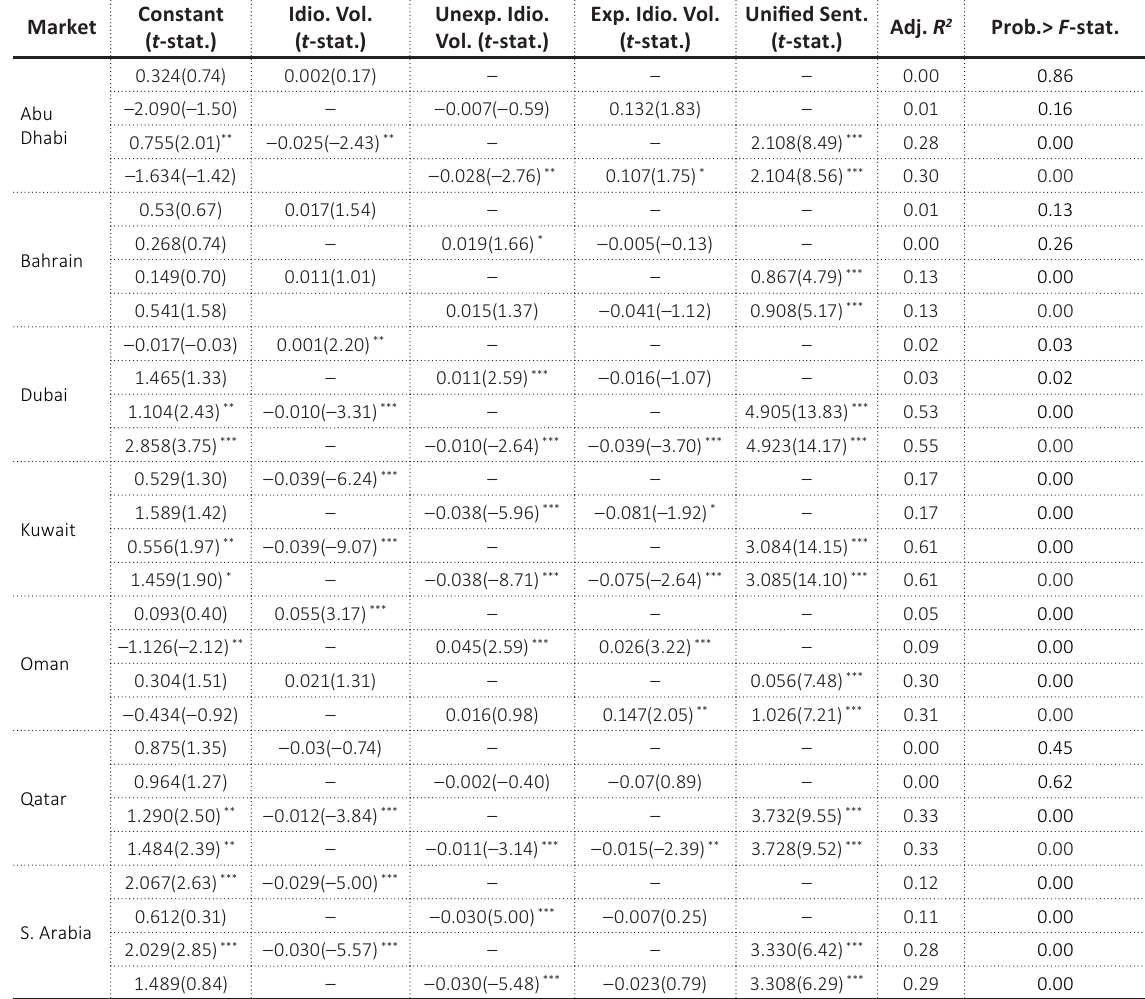
Table 1. Impact of idiosyncratic volatility and sentiment on individual market returns